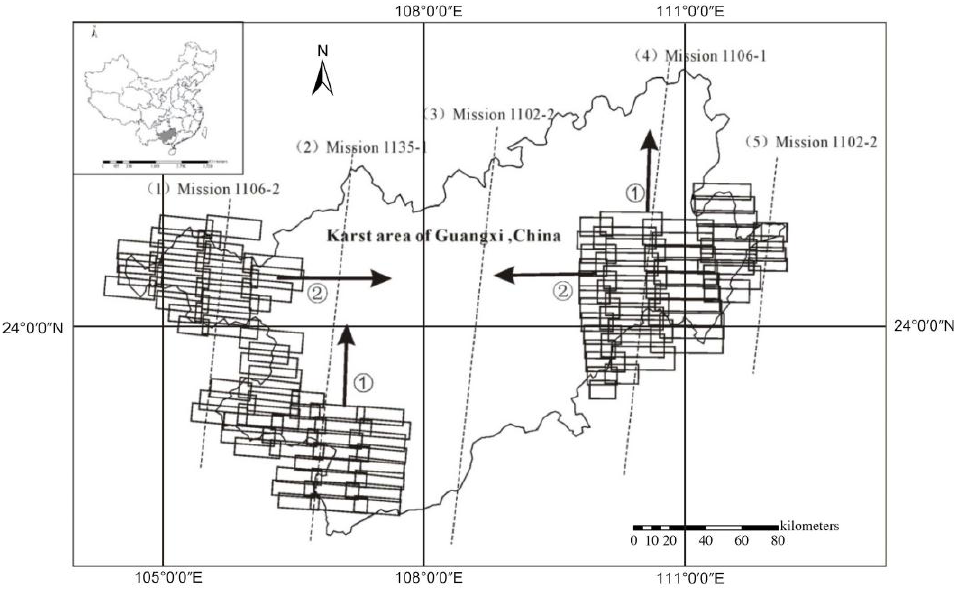
Figure 9. Mosaicking process from east/west to the middle.